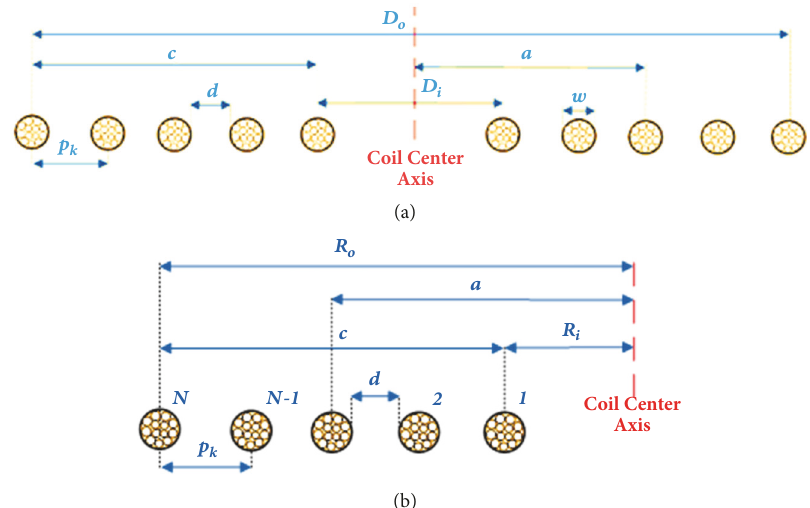
Figure 6: Coil cross-section, entire one (a) and half one (b).